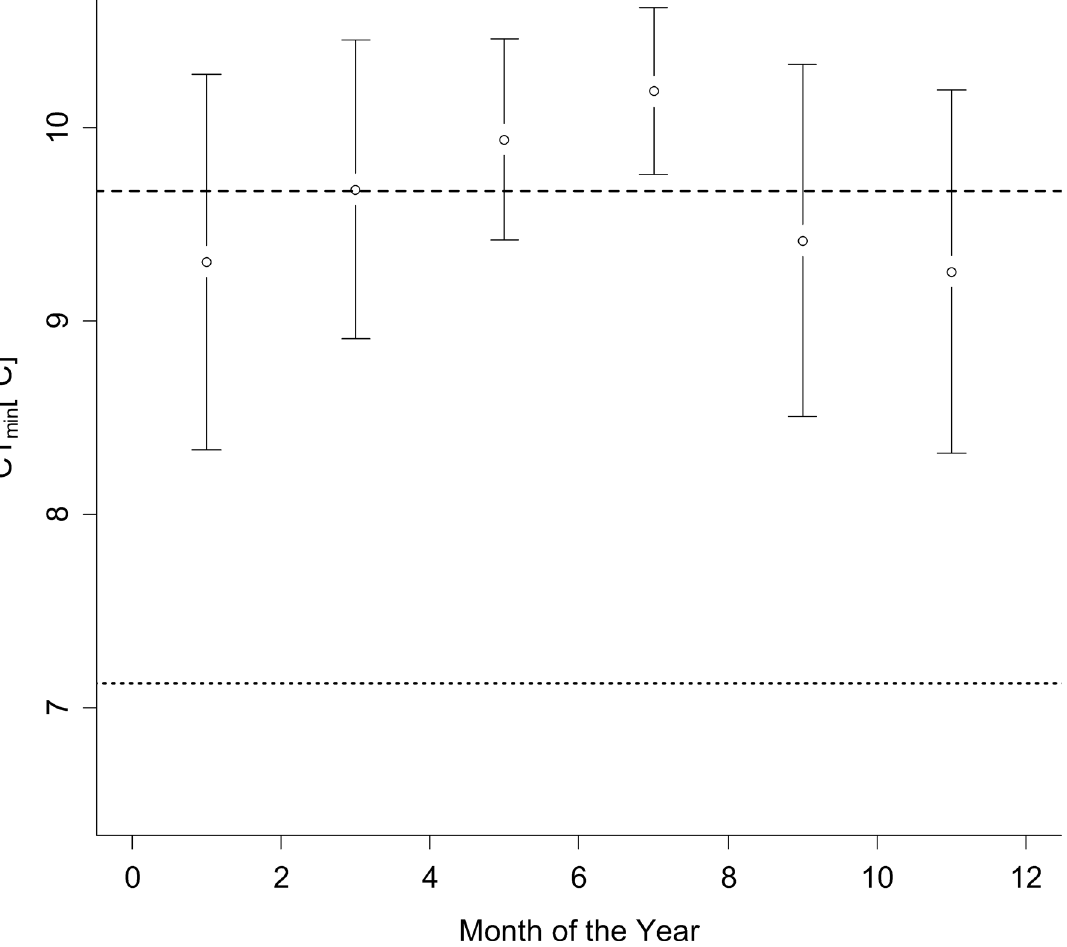
Fig 2. Acclimation of CT min in wild Carlia longipes . Critical thermal minimum temperatures [°C ± 2SE] of wild individuals (3 to 8 individuals per group) of Carlia longipes collected in different months of a year. No statistically significant differences were observed (ANOVA: F (5, 25) = 1.05, p = 0.4). Lines show mean CT min of wild animals (9.67°C; dashed) and predicted cold acclimated CT min of an average-sized animal of 4.88 g body mass (7.13°C; dotted).